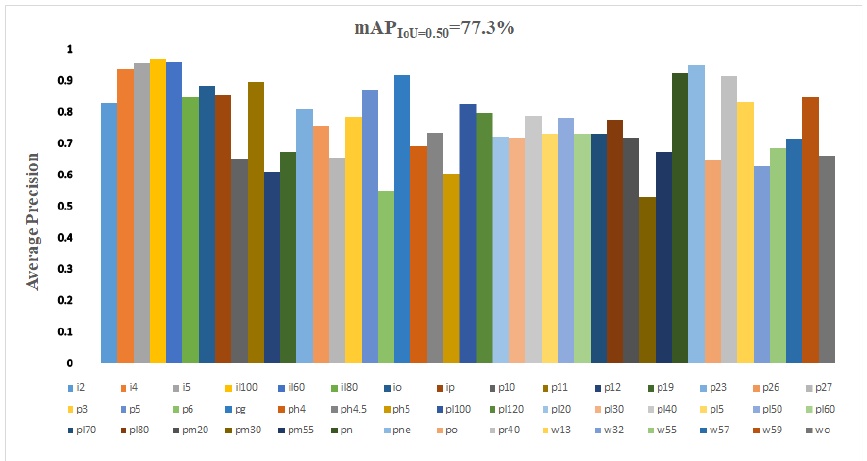
Figure 13. Test results of M-YOLOv3 on TT100K.